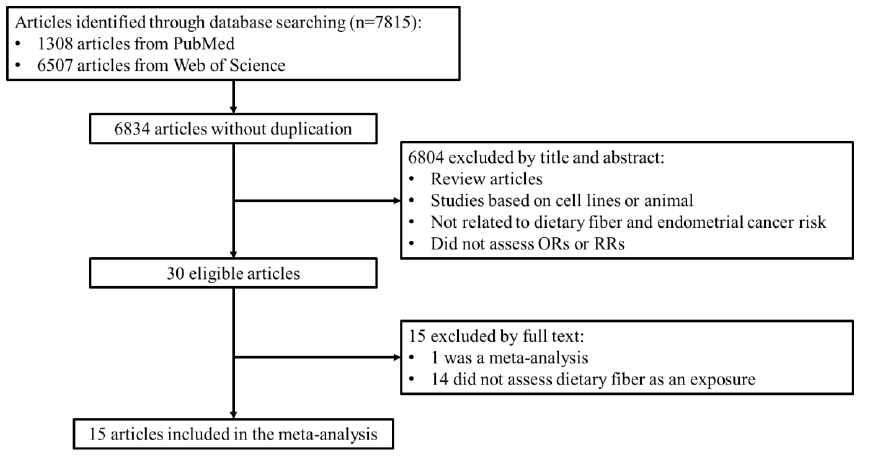
Figure 1. Study flow diagram.